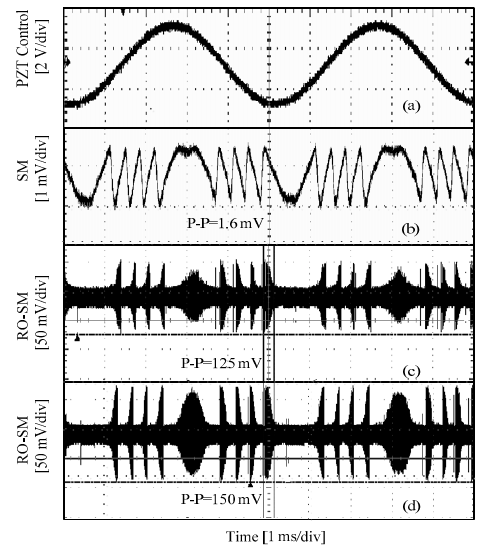
Figure 6. Experimental signals with J = 46 mA and L 0 = 12.5 cm for DL5032-001 ( a ) PZT control signal; ( b ) conventional SM signals at stable region; ( c , d ) RO-SM signals at semi-stable region.